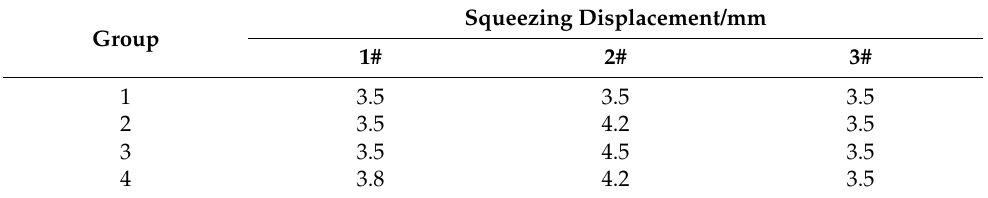
Table 2. Vertical Offsets of Rivets.